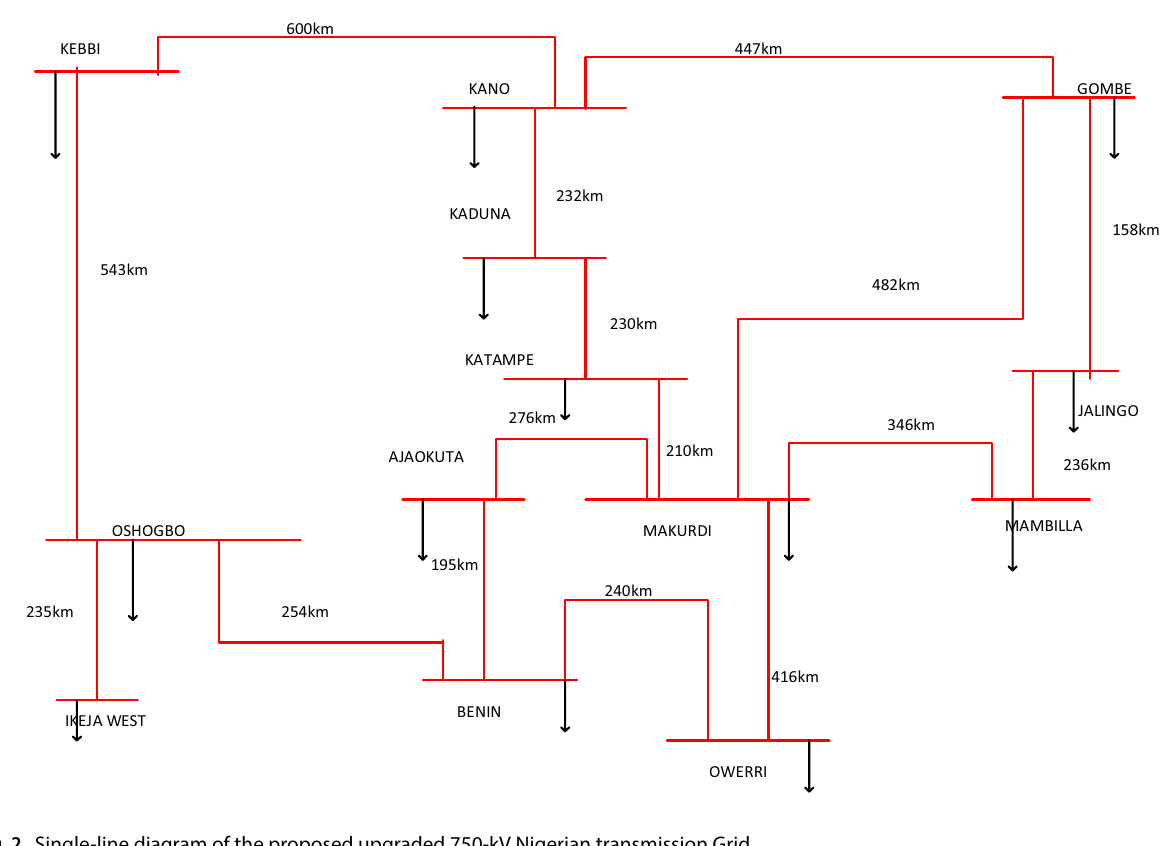
Fig. 2 Single-line diagram of the proposed upgraded 750-kV Nigerian transmission